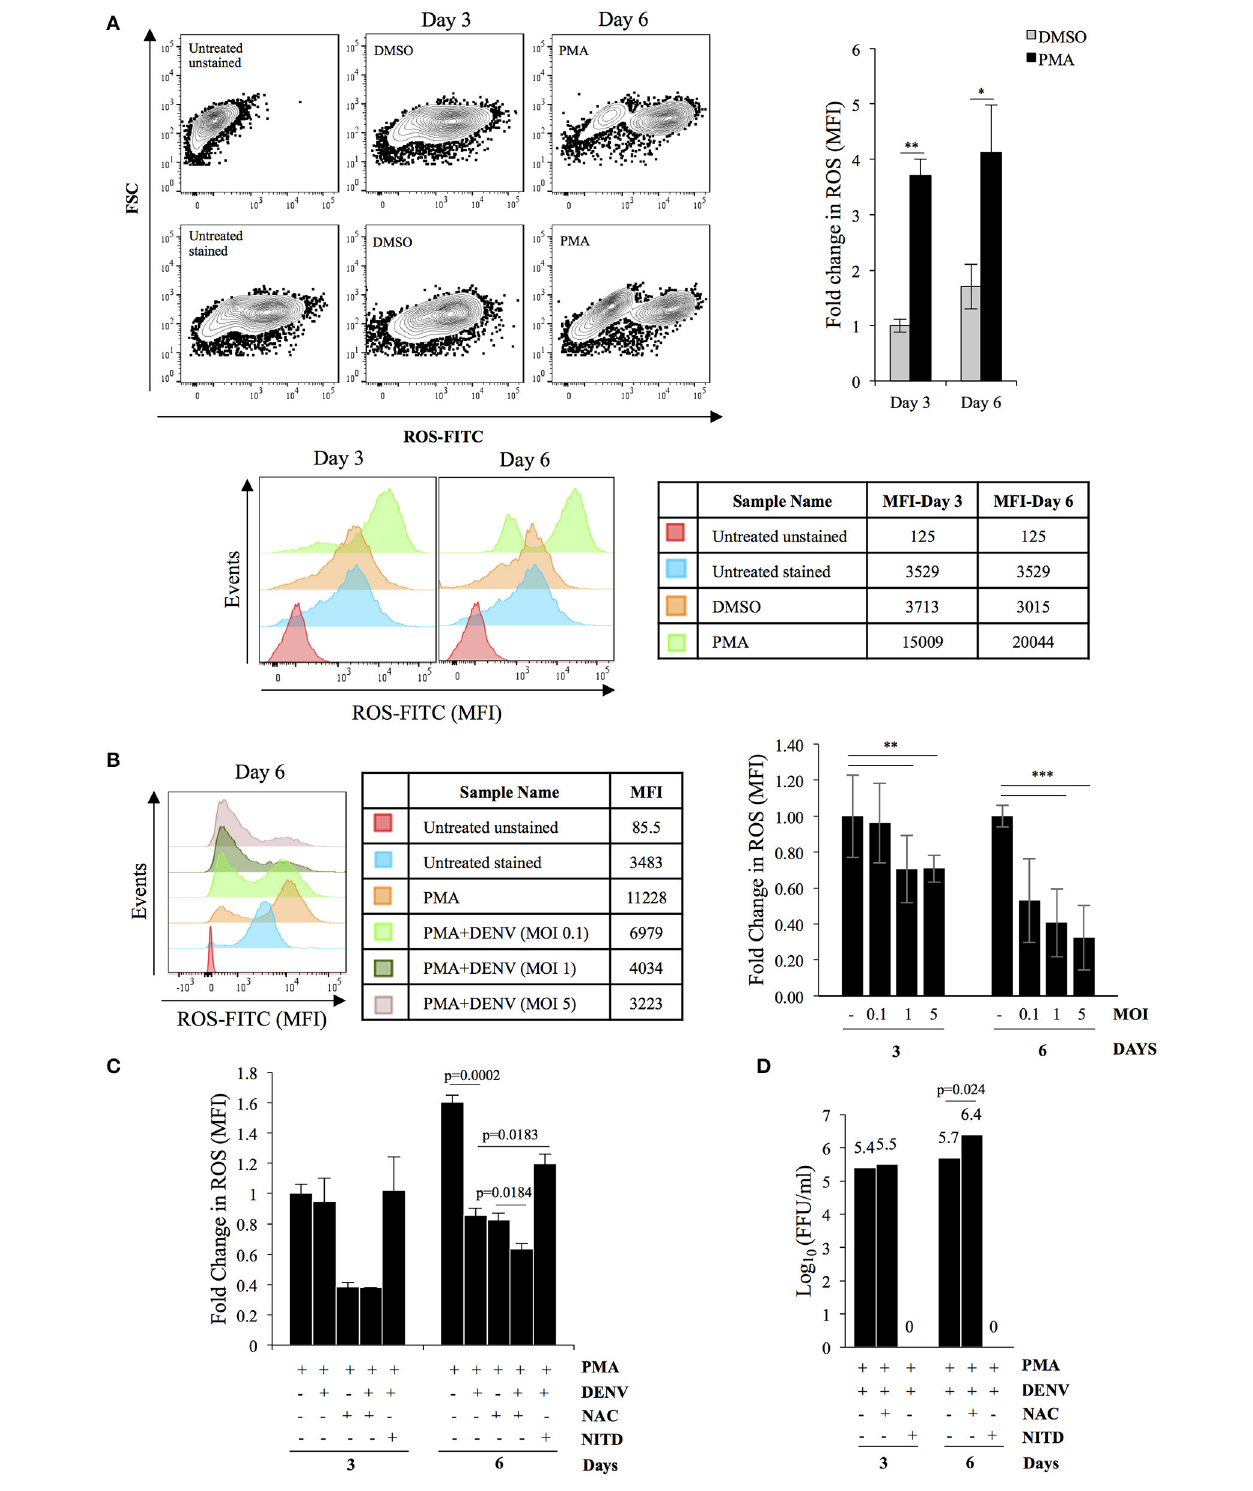
FIGURE 4 | DENV replication suppresses PMA-induced ROS accumulation. (A) PMA-induced differentiation leads to ROS accumulation. K562 cells either untreated or treated with either DMSO or 50nM PMA for a period of either 3 or 6 days, were stained with H 2 DCFDA and the fluorescence quantified in a flow cytometer. The relative fold change in MFI in cells treated with either DMSO or PMA- was plotted. (B) DENV infection suppresses ROS accumulation. Cytosolic ROS in K562 cells